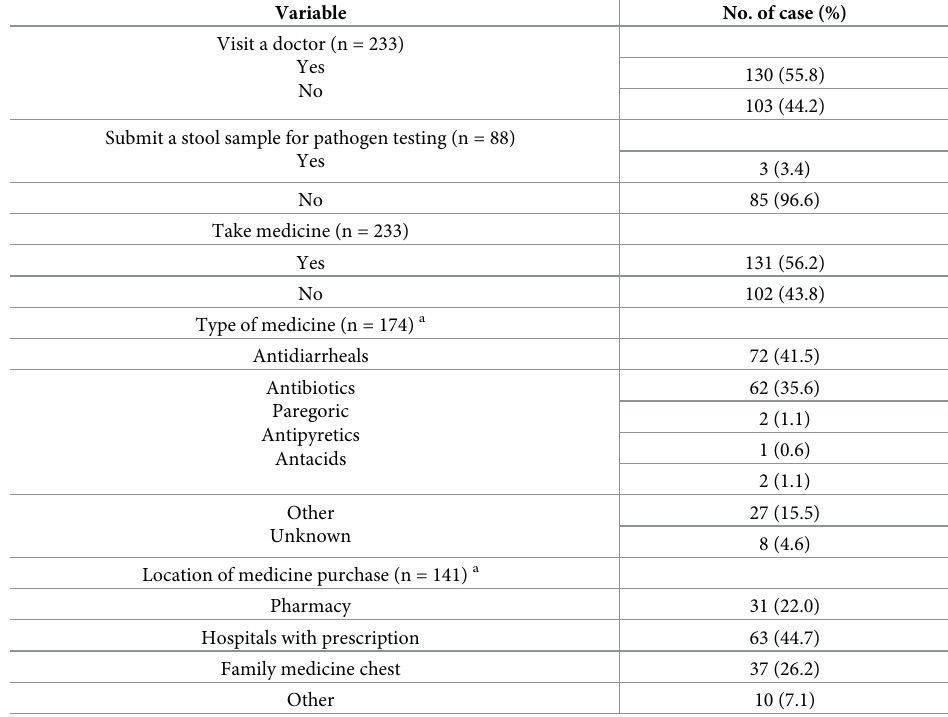
Table 4. Hospital visit and medicine use by participants with acute gastrointestinal illness in the 4 weeks prior to interview in Zhejiang Province, July 2018-June 2019.